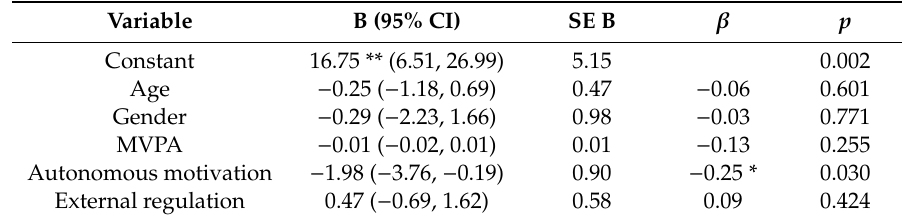
Table 3. Simultaneous multiple regression analysis exploring the relationship between Strengths and Di ffi culties Questionnaire (SDQ) total score and Behavioural Regulation in Exercise Questionnaire (BREQ) autonomous motivation and external regulation for exercise scores. Variable B (95% CI) SE B β p Constant 16.75 ** (6.51, 26.99) − 0.29 ( − 2.23, 1.66)